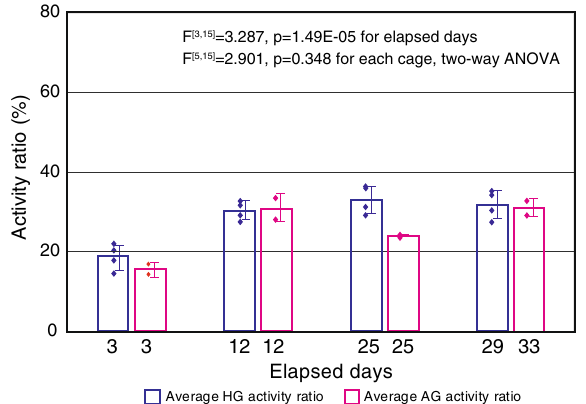
Figure 4. Comparison of HG and AG activity ratio. The horizontal axis is elapsed days, and the vertical axis is HG and AG activity ratio (%). Boxes are average activity ratios, and dots are activity ratios. The last day of AG is 33 days, and the last day of HG is 29 days, so they were considered the same